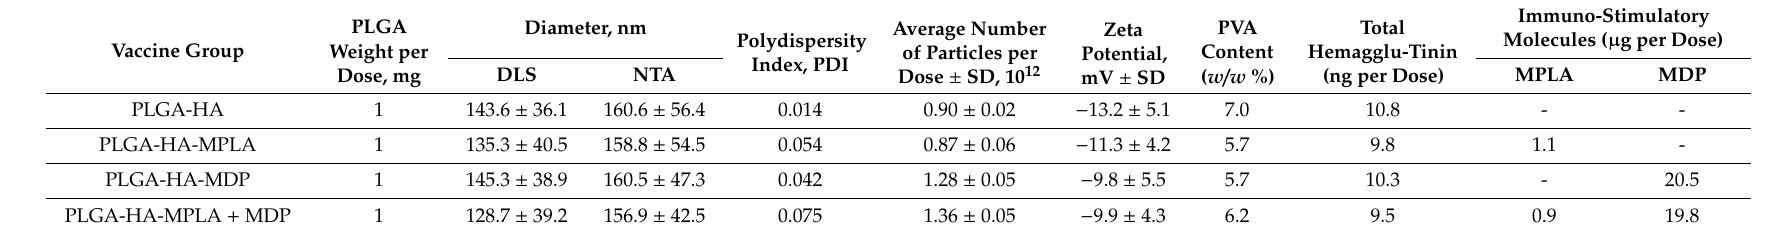
Table 1. Physico-chemical parameters of vaccine formulations ( n = 3; Mean ±